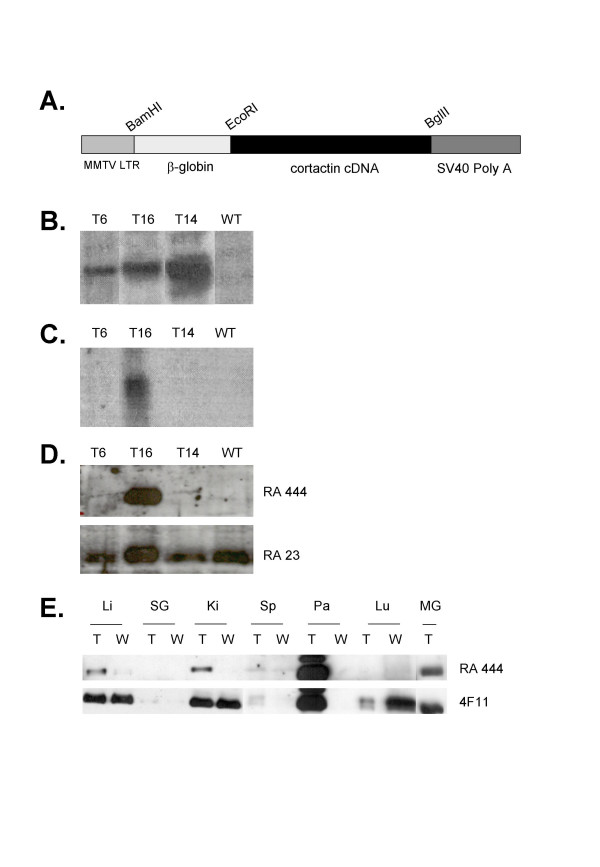
Analysis of cortactin transgene expression. (A) Structure of the MMTV-cortactin transgene construct. Vertical striped bar, 510 bp promoter/enhancer of the MMTV-LTR (-360/+150); stippled bar, 920 bp β-globin intron 2 sequence inserted to generate a stable transgene mRNA; black bar, 1.8 kb human EMS1 cDNA [29]; hatched bar, transcriptional processing sequences derived from SV40. Relevant restriction sites are indicated. (B) Southern blot analysis of tail DNA of three cortactin transgenic founders and one wild type (WT) mouse. The intensity of the bands corresponds to the increased copy number of the integrated transgenic cortactin cDNA. T6 contains one cDNA copy. (C) Northern blot analysis of 10-days lactating mammary glands. Expression of human transgenic cortactin mRNA (3,6 kb) was detected in T16 only. Full-length human cortactin cDNA was used as a probe. (D) Western blot analysis of 10-days lactating mammary glands to detect transgenic cortactin protein expression. Polyclonal antibody RA444 was used to recognize specific human transgene expression, whereas polyclonal antibody RA23 recognized both human and endogenous mouse cortactin. (E) Virgin T16 transgenic (T) and non-transgenic (W) female mice were treated with glucocorticosteroid dexamethasone to stimulate transgene expression from the MMTV promoter. Lysates from liver (Li), salivary gland (SG), kidney (Ki), spleen (Sp), pancreas (Pa), lung (Lu) and 10-days lactating mammary gland as a positive control (MG) were subjected to Western blotting. Polyclonal antibody RA444 was used to detect specific human transgene expression, whereas monoclonal 4F11 antibody recognizes both human and mouse cortactin. Transgene expression was significantly induced in the pancreas, liver and kidney.